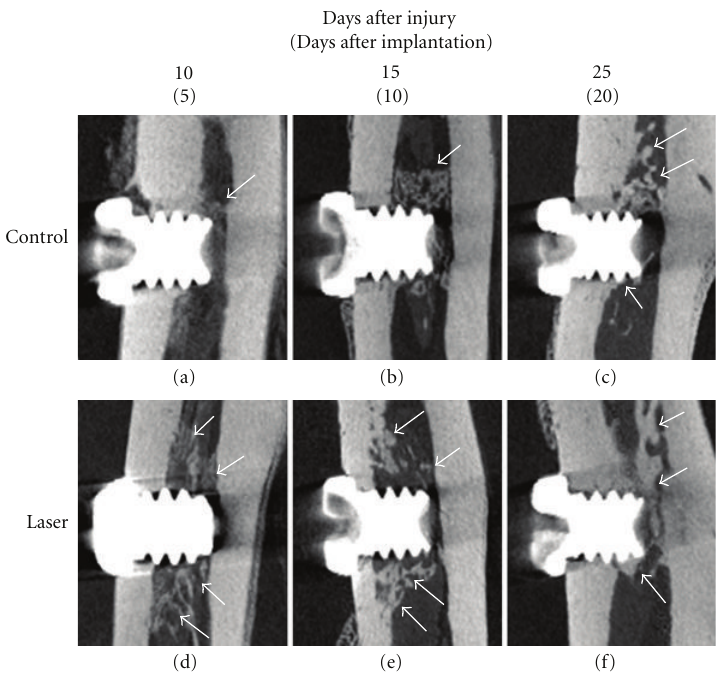
Figure 3: Micro-CT images. (a, d): 5 days after implantation (10 days after sham operation or laser irradiation). (b, e): 10 days after implantation (15 days after sham operation or laser irradiation). (c, f): 20 days after implantation (25 days after sham operation or laser irradiation). (a–c): control group tibia. (d–f): laser group tibia. Arrow indicates newly formed